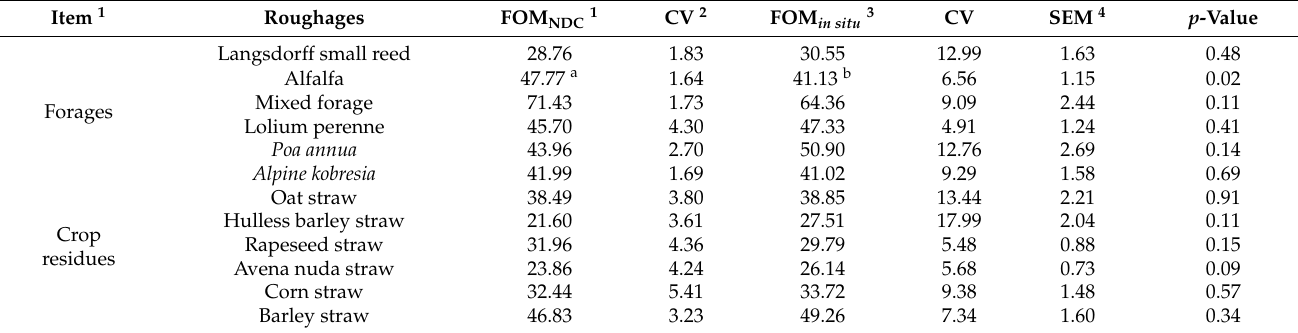
Table 4. Comparison between FOM NDC and FOM in situ of roughages (DM basis, expressed as %). Item 1